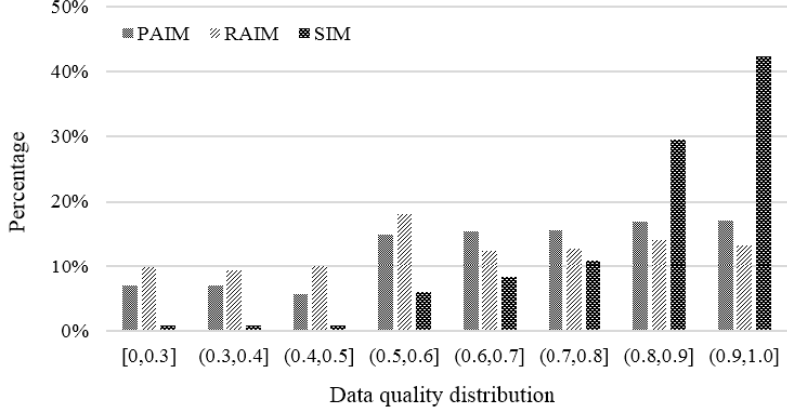
Figure 9. Comparison of data quality distribution.